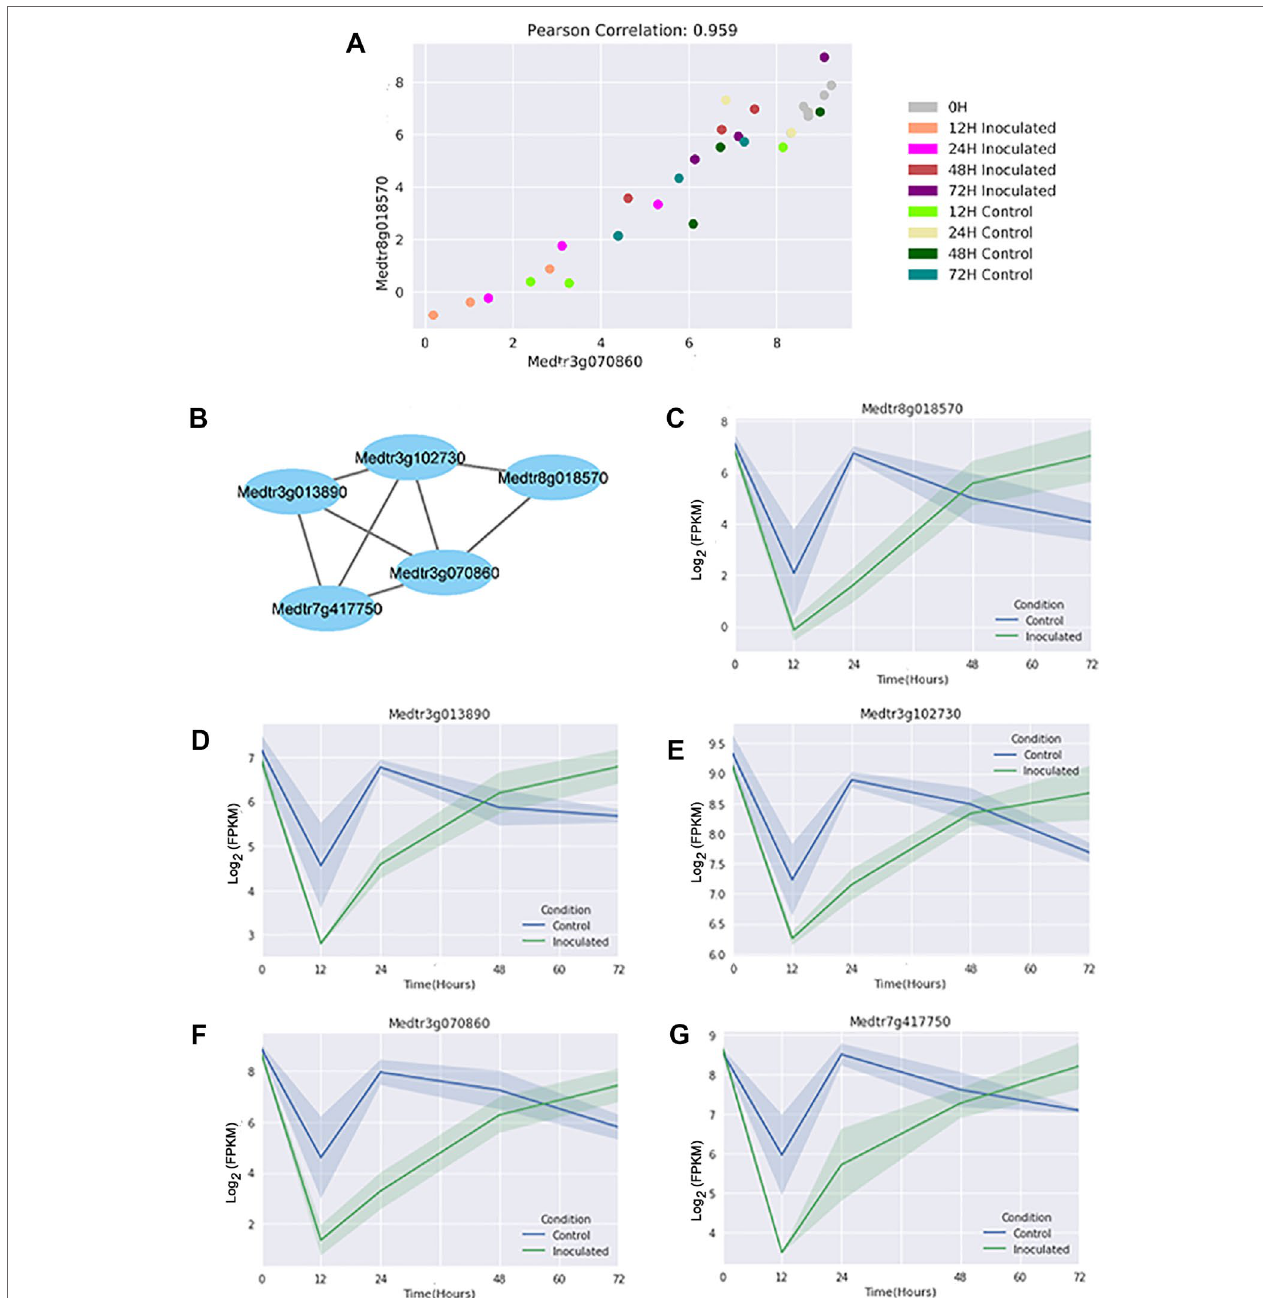
FIGURE 4 | A representative gene co-expression network edge and link community module. (A) In this example, the Log 2 fragments per kilobase of gene per million read pairs (FPKMs) of two genes selected from the module are plotted on the X and Y axis respectively. They show a high correlation value across all samples, both inoculated and control. (B) Relationships of the genes in the module. Edge length has no meaning beyond connection. (C – G) Expression plots (Log 2 FPKMs versus time) for the individual genes in the module reveal that all genes have differential expression at the 24 h time point, but additionally share expression patterns at the other time points. Shading indicates 68% confidence interval of three independent replicates, and the point where genes are differentially expressed is marked-in this case where the shading does not overlap.